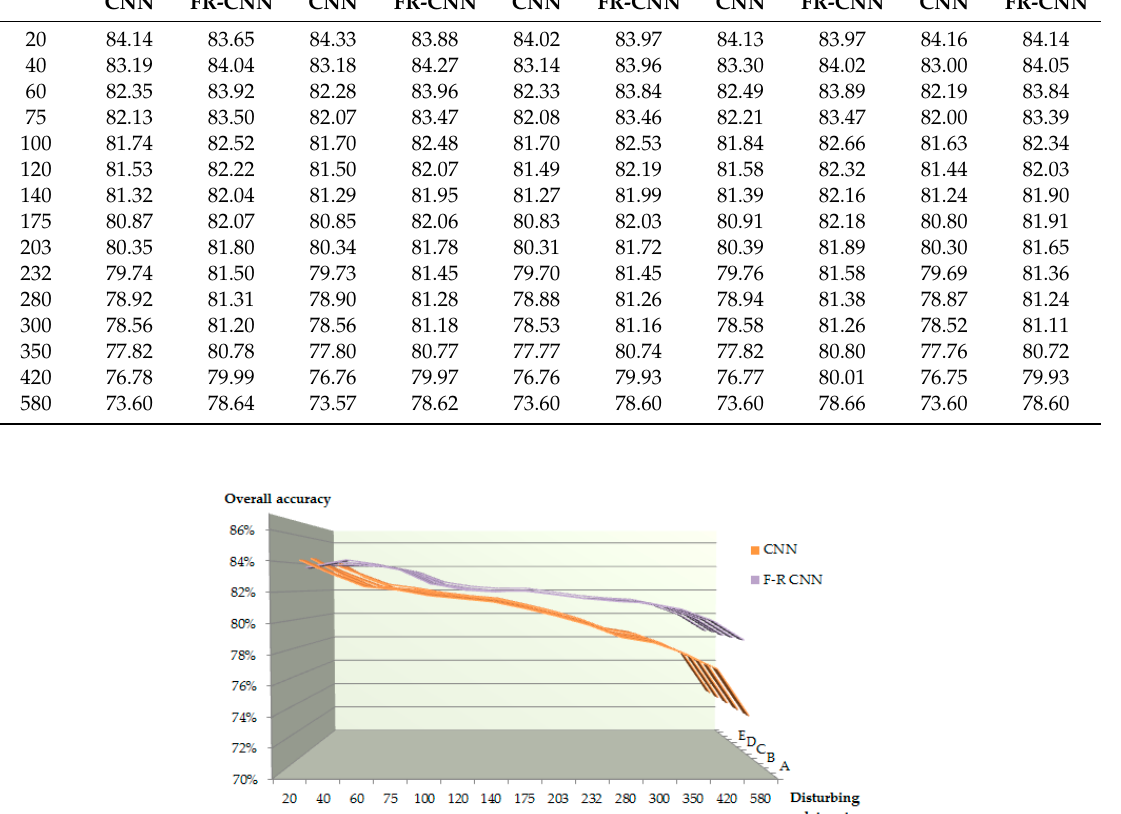
Figure 8. Classification accuracy evaluation of different batches of training numbers in two models. Data A, B, C, D and E represent 20 times the training samples of different disturbance levels.